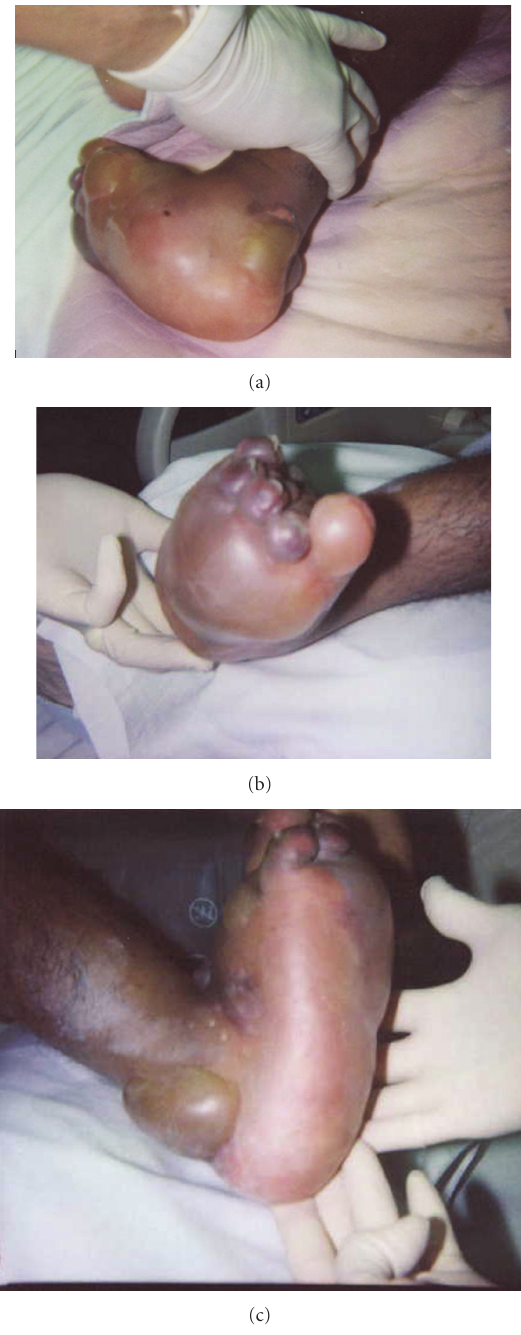
Figure 1: Multiple views of the patient’s right foot demonstrate severe blistering and